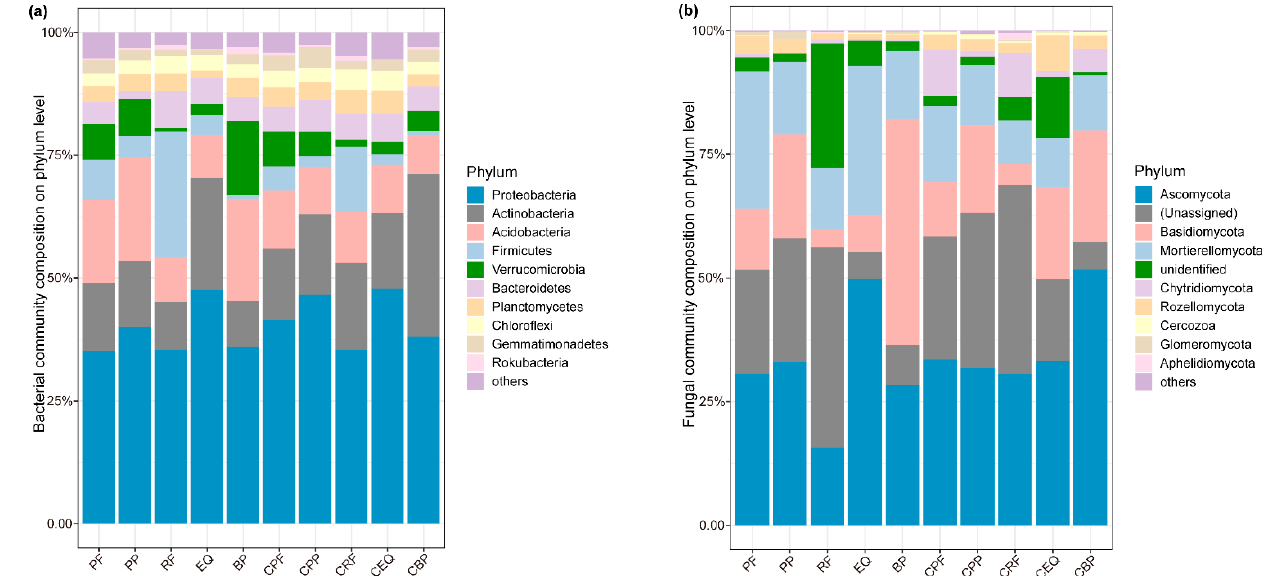
Figure 2. Relative abundance of ( a ) bacterial and ( b ) fungal compositions at the phylum level. PP, PF, RF, EQ, and BP refer to the background (inoculum) soils of Poa poophagorum , Potentilla fragarioides , Rhododendron fortunei , Enkianthus quinqueflorus , and Betula platyphylla , respectively. CPP, CPF, CRF, CEQ, and CBP refer to the soil conditioned by the above species.